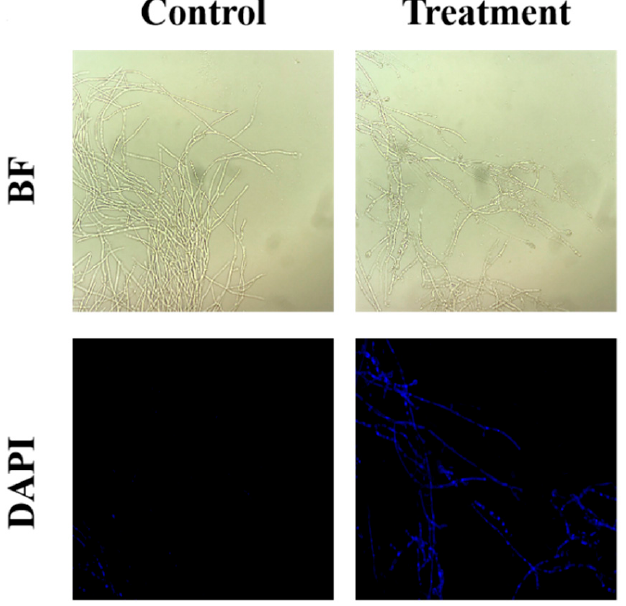
Figure 3. Effect of B. subtilis XZ18-3 sterile filtrates on DNA damage in R. cerealis . The fluorescence excitation wavelength is 340